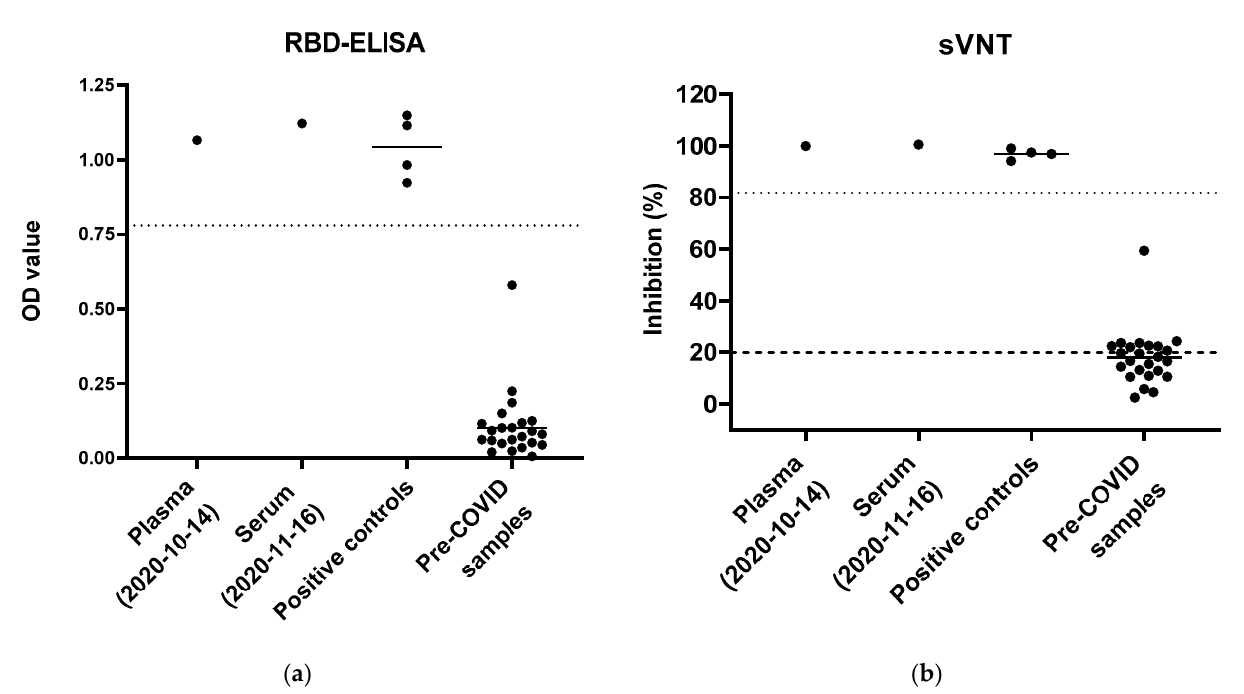
Figure 2. Serological results from blood collected in October and November 2020. Positive controls ( n = 4) and pre-COVID sera ( n = 24, collected before 5 January 2020) were run in parallel in both assays. ( a ) Enzyme-linked immunosorbent assay (ELISA) for the detection of anti-SARS-CoV-2 spike protein receptor binding domain (RBD) antibodies. Results are presented by optical density values (OD) and were measured at 415 nm. The mean OD is shown as a line within the group. The dotted line shows the positive cut-off value set at 0.78. ( b ) A surrogate virus neutralization test (sVNT) was used to measure neutralizing activity. The dashed line indicates the positive cut-off set for human samples by the manufacturer at ≥ 20%, and the dotted line indicates the positive cut-off calculated at 81.8%.